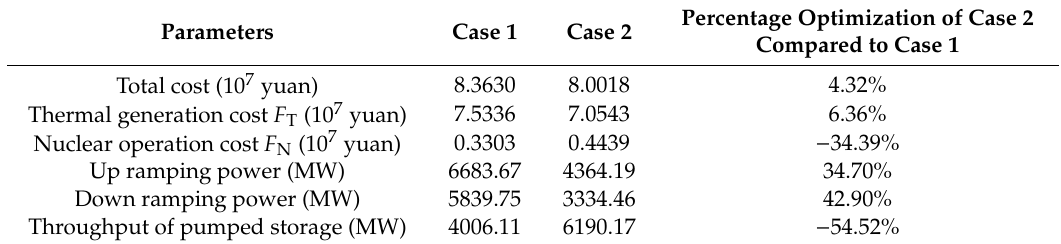
Table 2. Result comparison of Case 1 and Case 2 in a day.